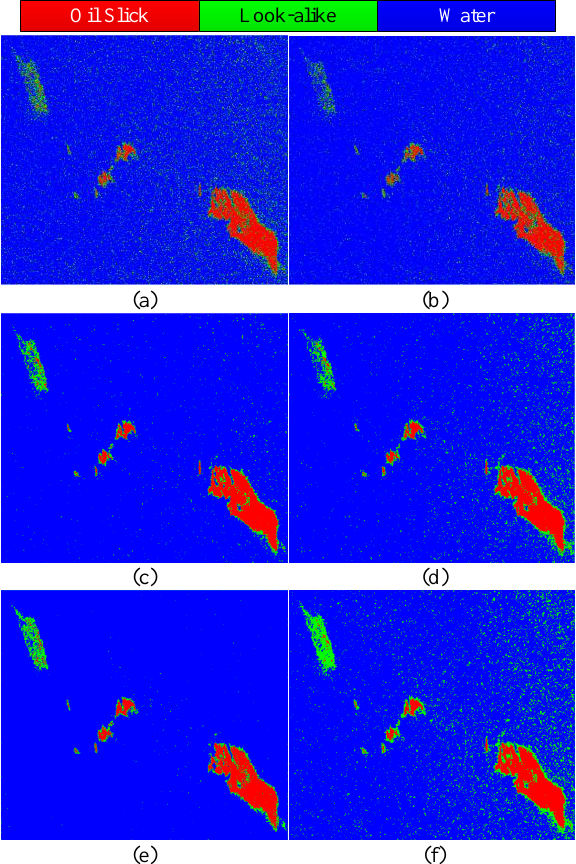
Figure 4. K-means classification of six polarimetric features in